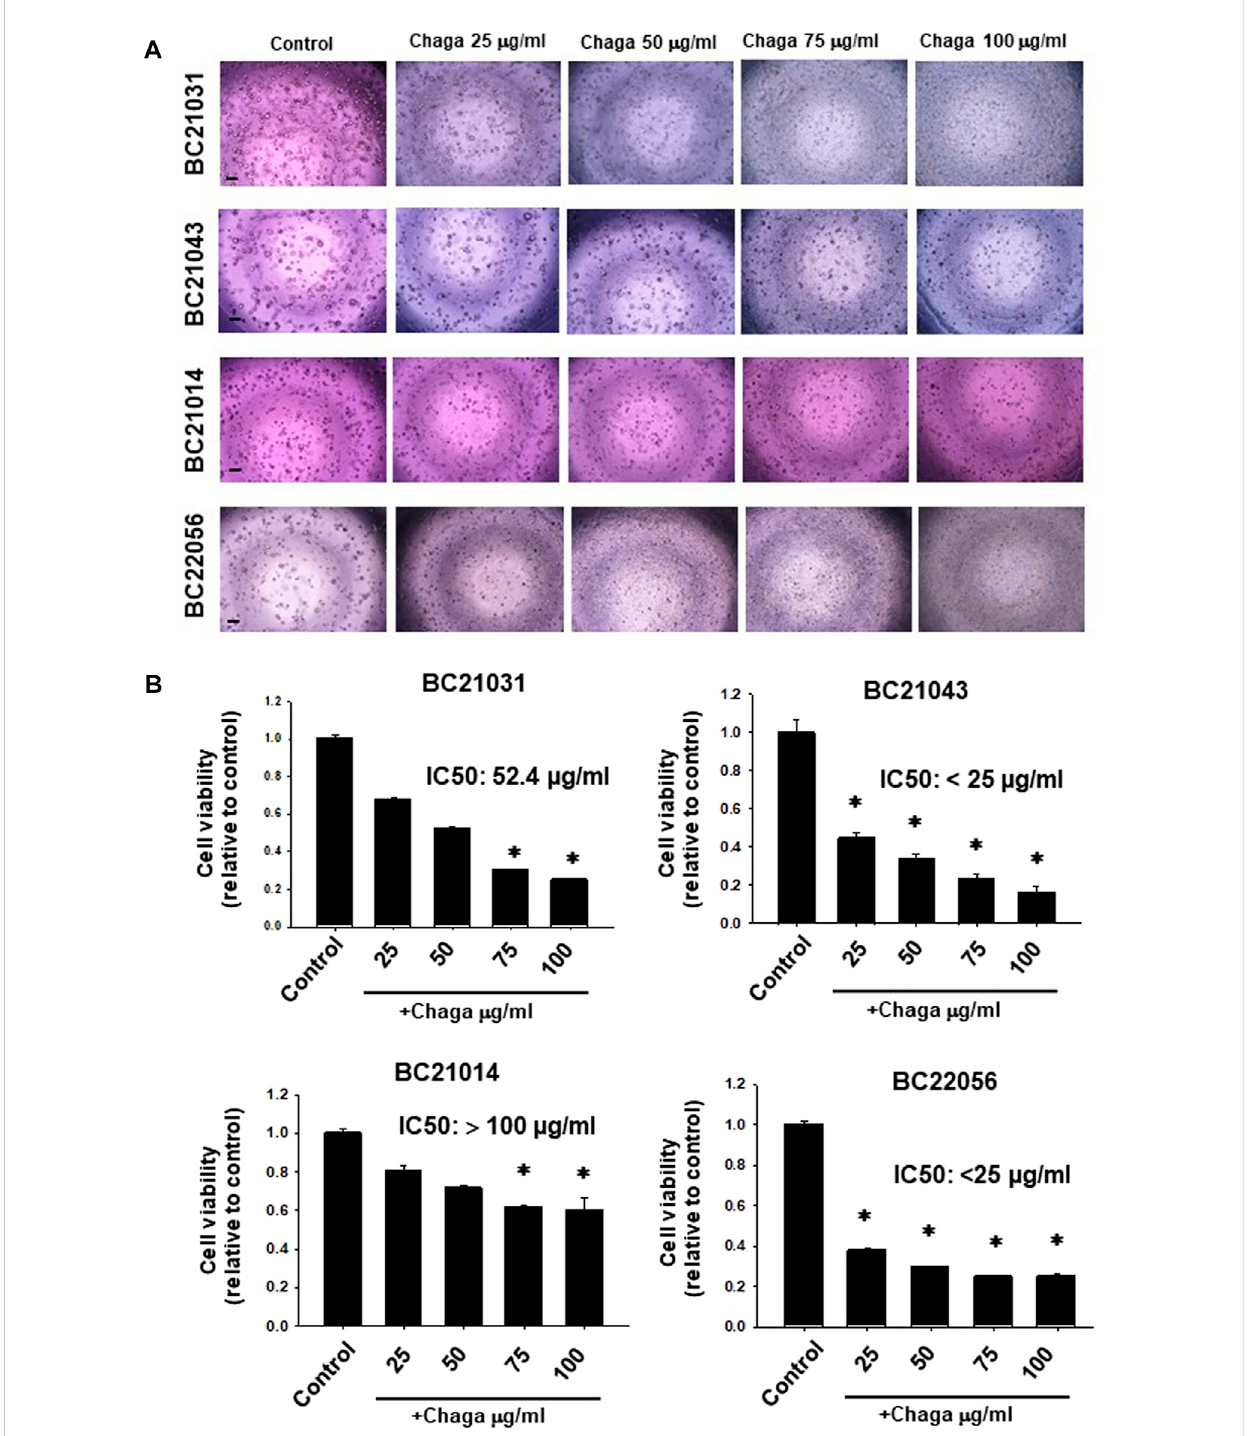
FIGURE 1 Effects of Chaga on cell viability of dog bladder cancer organoids (DBCO). Representative phase-contrast images (scale bar: 500 μ m) of the sensitivity of four strains of DBCO (BC21031, BC21043, BC21014, and BC22056) to different concentrations (25, 50, 75, 100 μ g/ml) of Chaga for 72 h using Prestoblue cell viability assay (A) , n = 3 – 6) and its quanti fi cation (B) . The value 1 on Y-axis represents the cell viability of each control. Results were expressed as mean ± SEM. * p < 0.05 vs.